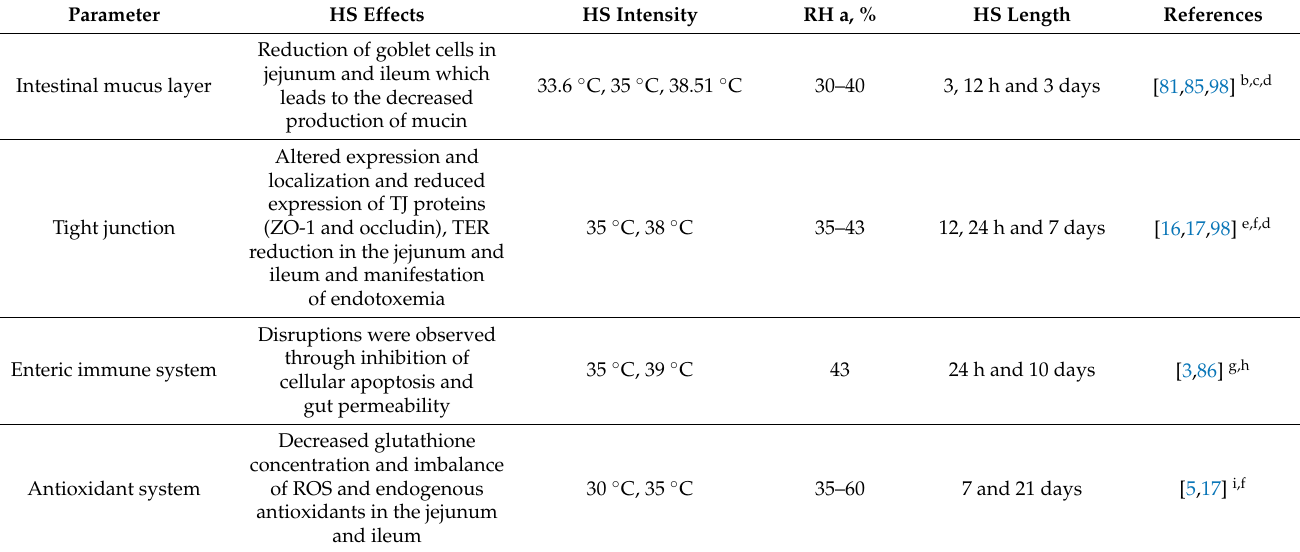
Table 2. Heat stress (HS) effects on the intestinal integrity and function of